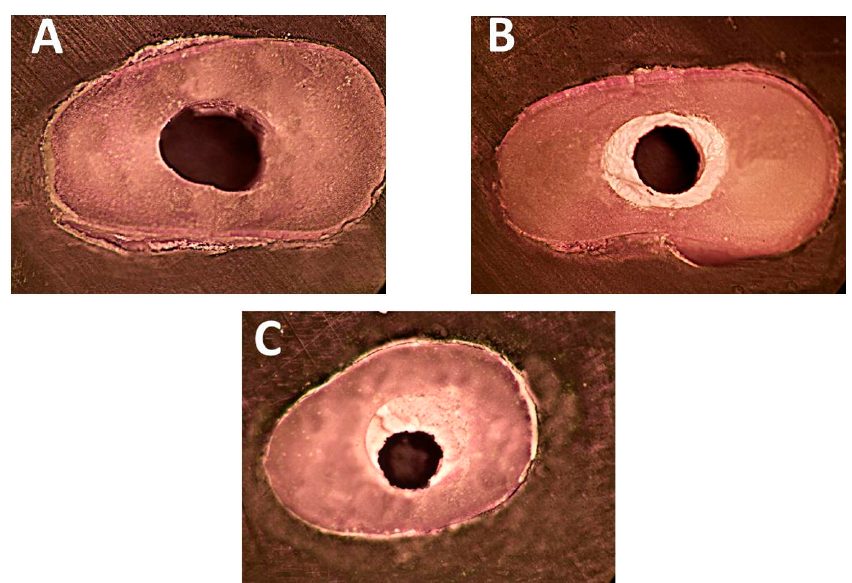
Figure 2. Stereo-photomicrographs of failure modes after push-out test at 50× magnification ( A ) Complete adhesive: the canal is completely clean, ( B ) Complete cohesive: the failure occurs within the EndoSequence material, ( C ) Mixed failure: Remnants of EndoSequence remain inside the canal.